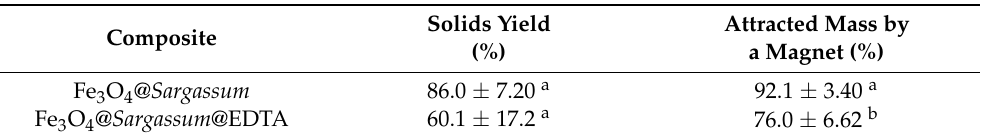
Figure 2. Response surface for the synthesis of the Sargassum composite as a function of ( A ) glutaraldehyde concentration (% w / v − 1 ) and EDTA concentration (g mL − 1 ), ( B ) the magnetic composite concentration (% w / v − 1 ) crosslinked with glutaraldehyde (% w / v − 1 ), and ( C ) the magnetic composite concentration (% w / v − 1 ) functionalized with EDTA (g mL − 1 ), to maximize the adsorption capacity of Hg 2+ . Table 2. The solids yield and attracted mass by a permanent neodymium magnet (1.4 T) of the magnetic composite with and without EDTA (mean ± SD, n =